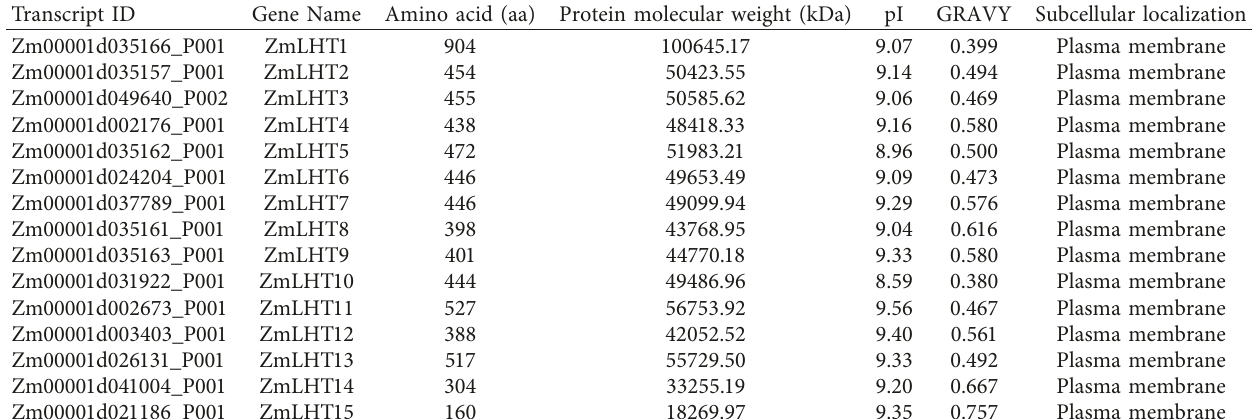
Table 1: The characterization and identification of the ZmLHT family in